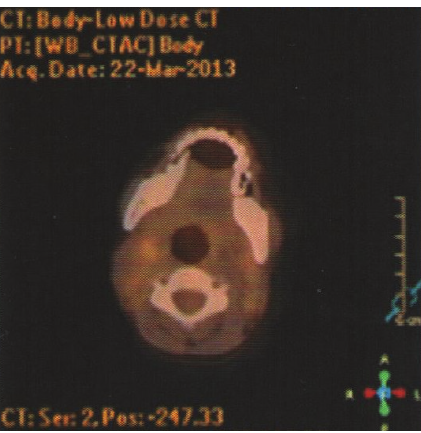
Figure 1: FDG-PET/CT, cervical lymph nodes. Figure 2: FDG-PET/CT, cervical lymph